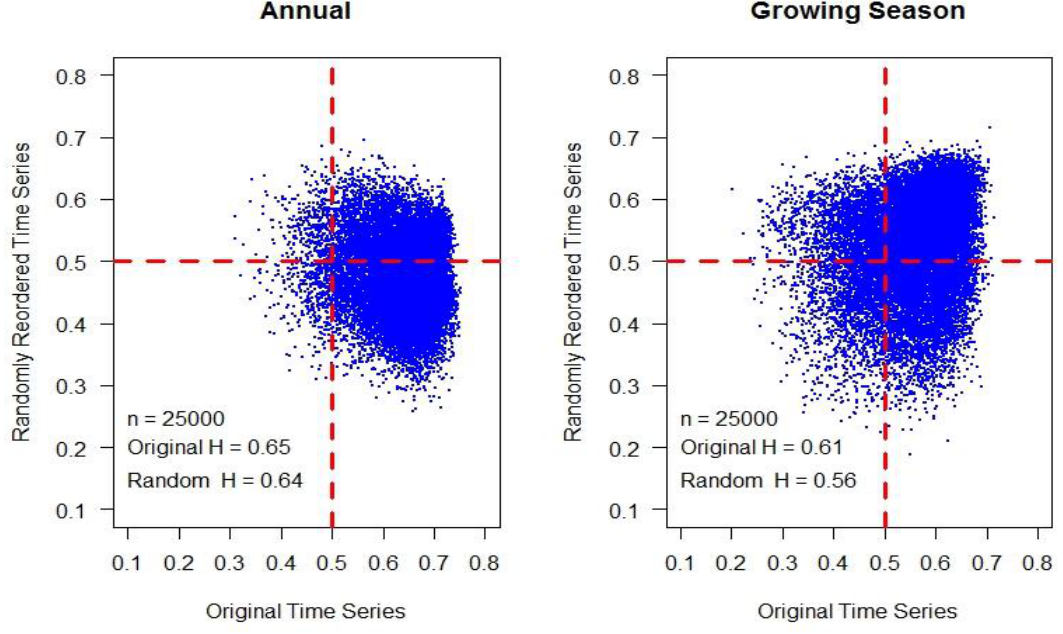
Figure 10. Scatterplot of annual and growing season between the Hurst’s exponents of original and randomly reordered time series.